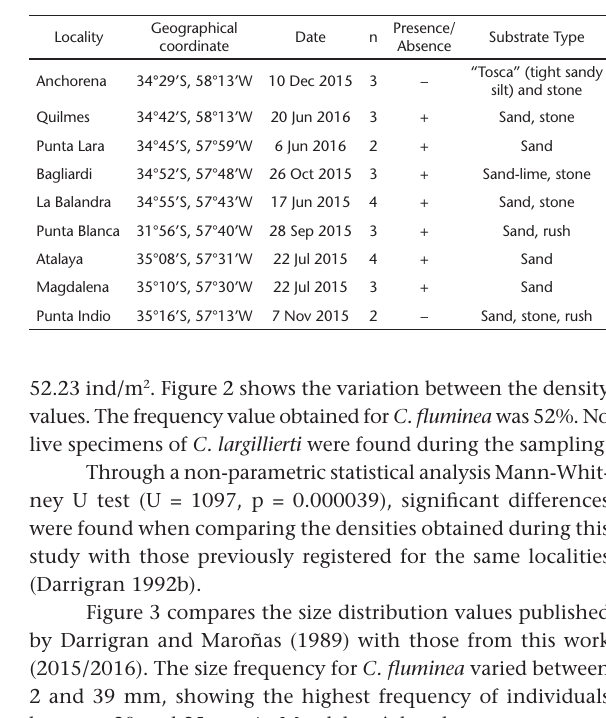
Table 1. Sampling localities. Geographical coordinates, sample date, number of samples (n), Presence (+), Absence (–) of C. fluminea and substrate